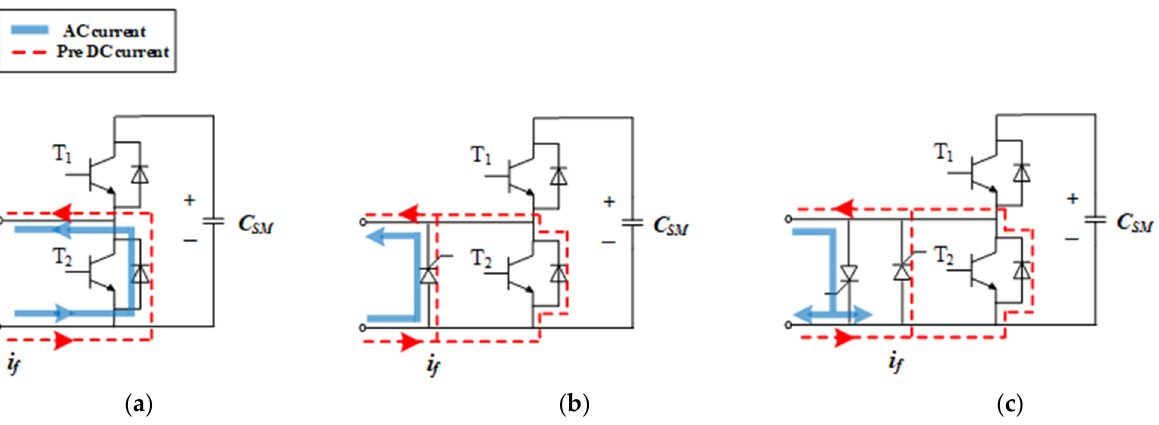
Figure 2. Conventional half-bridge sub-module (HBSM) under the faulty condition ( i f < 0), ( a ) an HBSM without a thyristor, ( b ) an HBSM with a single thyristor, and ( c ) an HBSM with double thyristors.